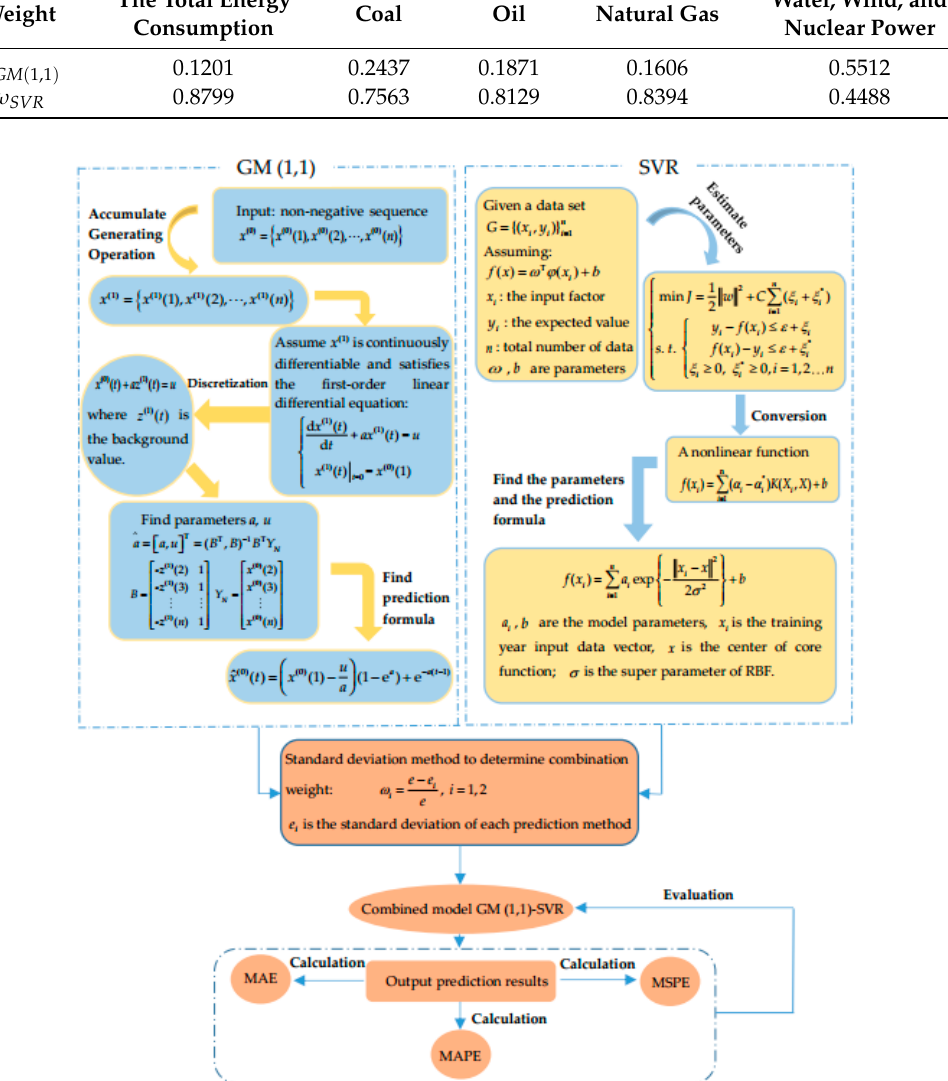
Figure 2. The procedure of GM (1,1)-SVR.